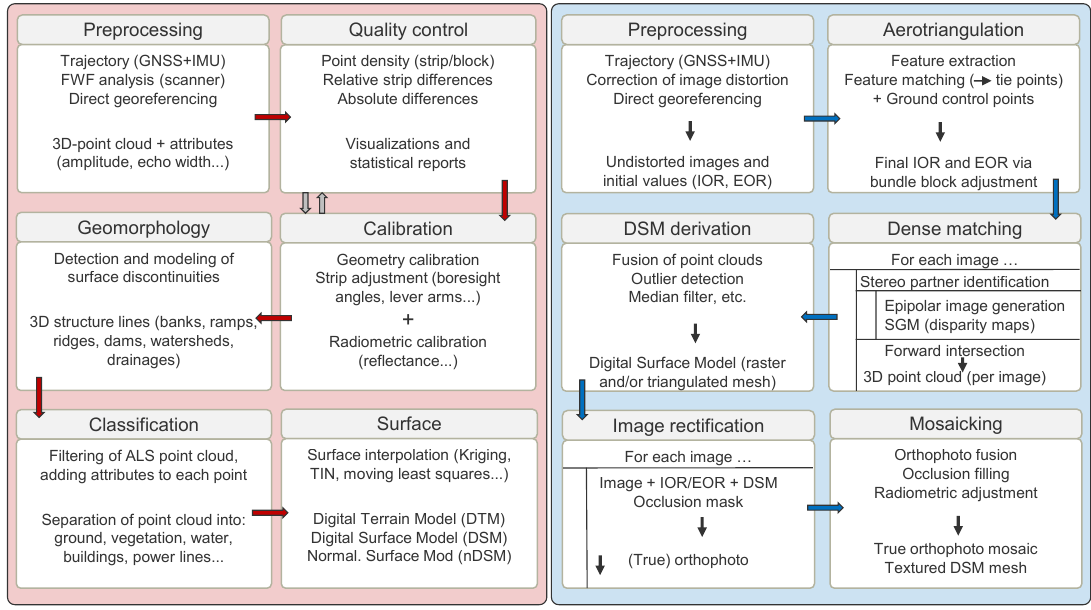
Figure 5. Schematic diagram of typical LiDAR and DIM processing chains